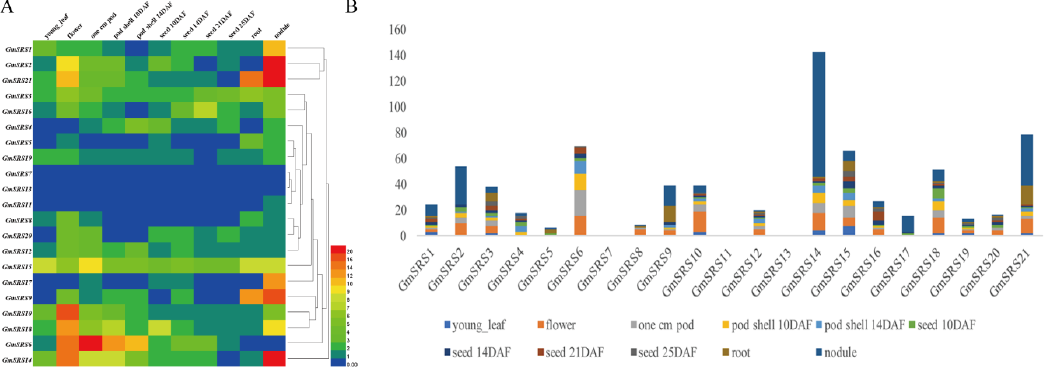
Figure 4. Expression patterns of soybean SRS genes in di ff erent tissues. The heat map ( A ) and histogram of soybean SRS genes expression patterns ( B ) in di ff erent tissues. The names are on the left and the tissue names are on the top of the figure, and the di ff erent colors indicate express degree of gene.